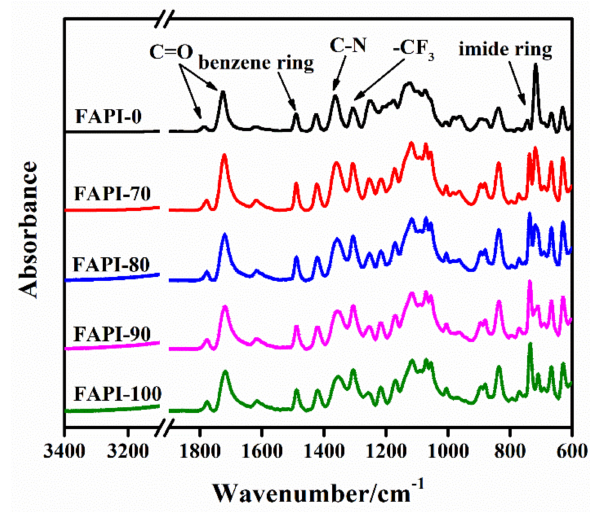
Figure 1. ATR-FTIR spectra of the FAPI films with different biphenyl group content in polymer backbone.